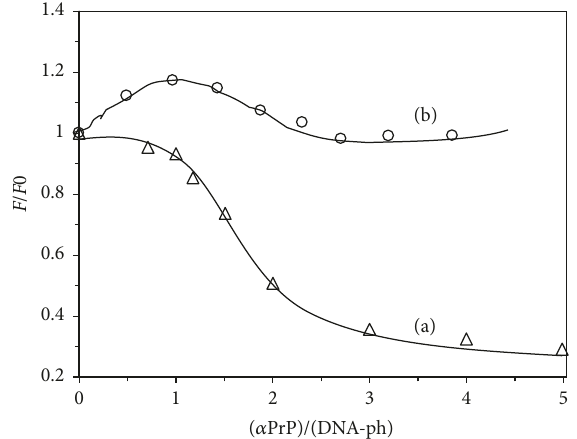
Figure 9: Dependence of fluorescence quenching of gcDNA bound YOYO with varying dye to DNA molar ratio in the presence of increasing 𝛼 -PrP concentrations. (a) Titration with dye: DNA-ph = 1: 50 and (b) with dye: DNA-ph = 1: 2000. Therefore dye: DNA-ph ratio = 1: 2000 used for the acrylamide accessibility experiments.